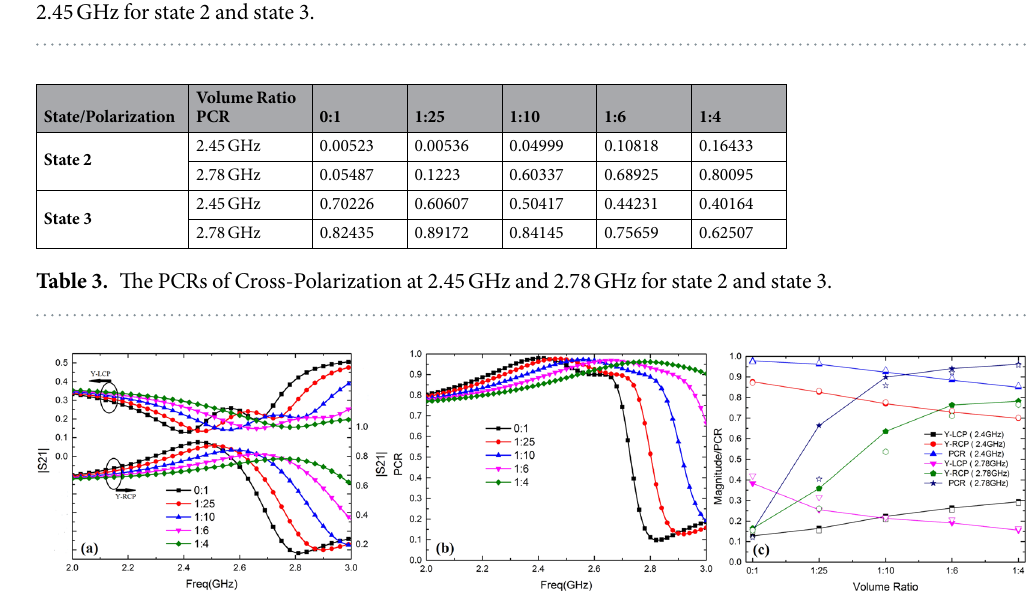
Volume Ratio PCR